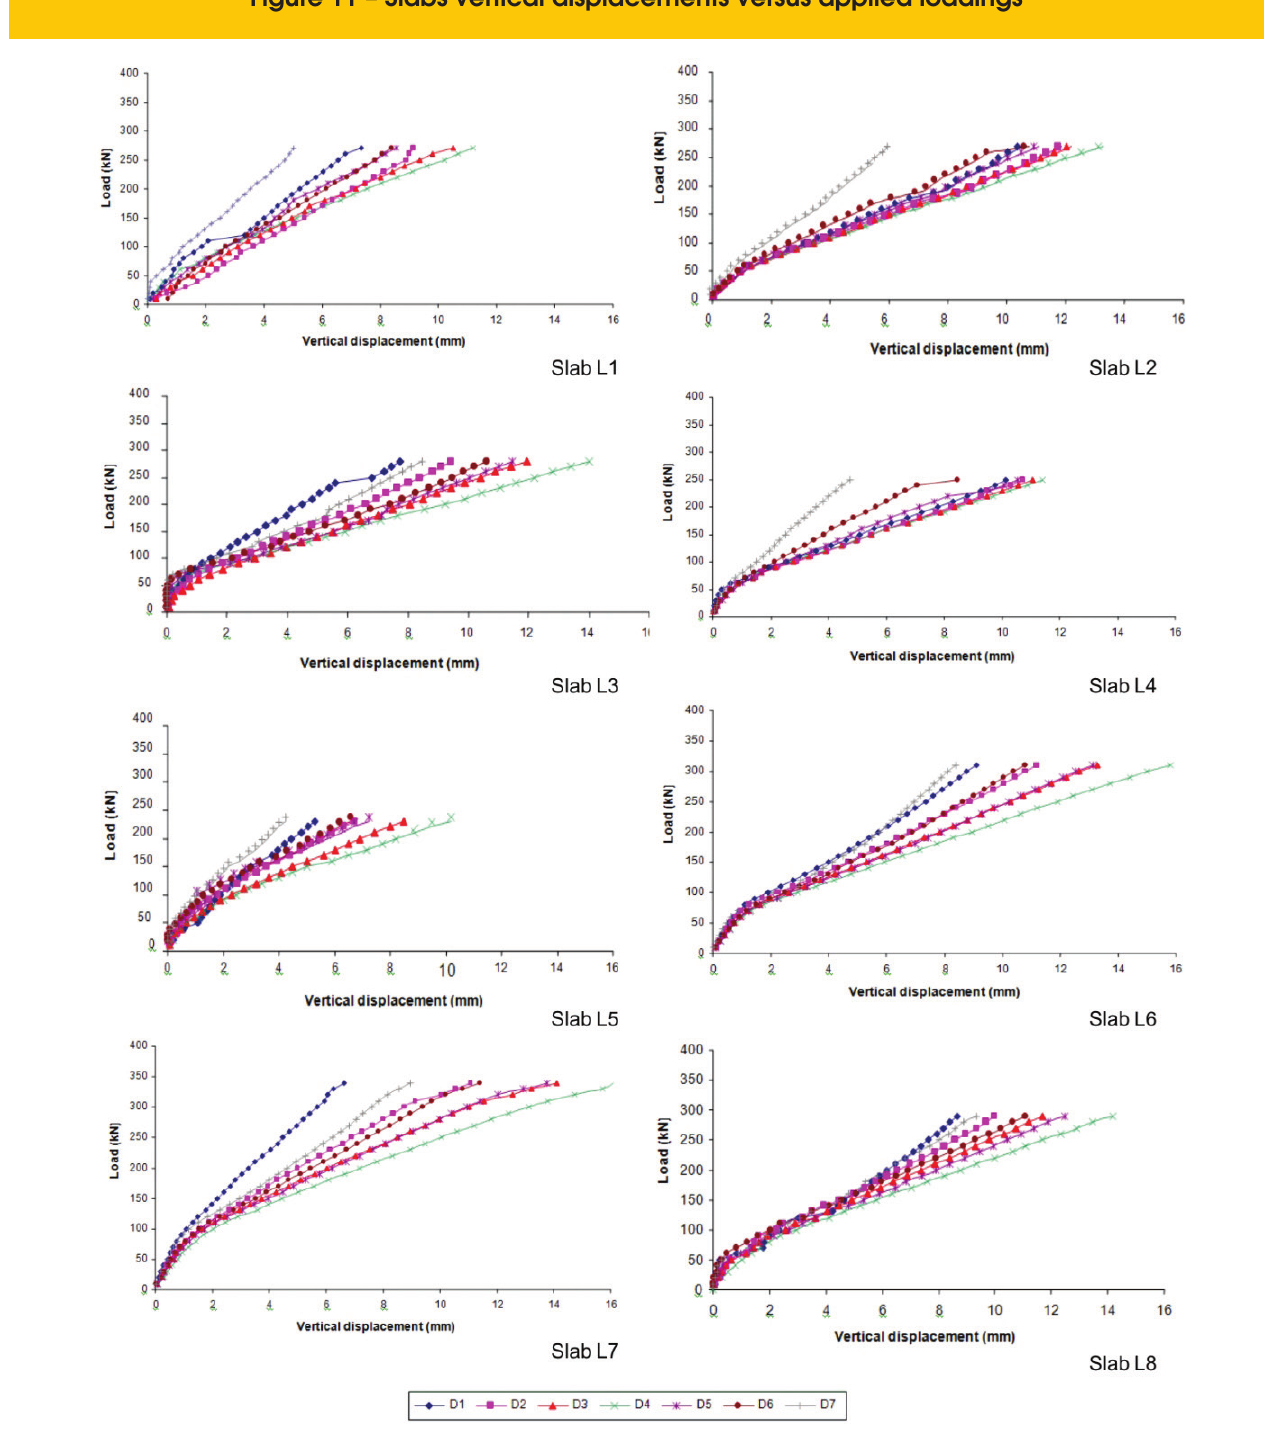
Figure 11 – Slabs vertical displacements versus applied